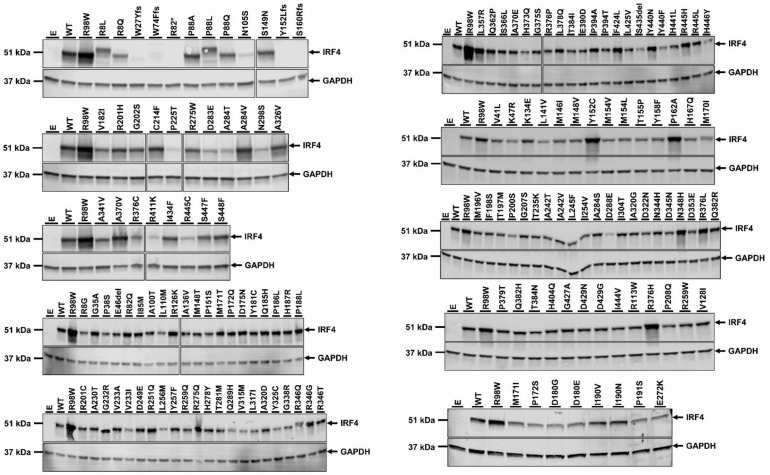
Protein levels of IRF4 variants previously reported in gnomAD database.HEK293T cells were transfected with the pcDNA3.1 empty vector (E), or plasmids encoding IRF4 WT, IRF4 R98W or several IRF4 variants previously reported in the gnomAD database (see Figure 3). Total cell extracts were subjected to western blotting; the upper panel shows IRF4 levels and the lower panel shows the levels of GAPDH, used as a loading control. The results shown are representative of at least two independent experiments.